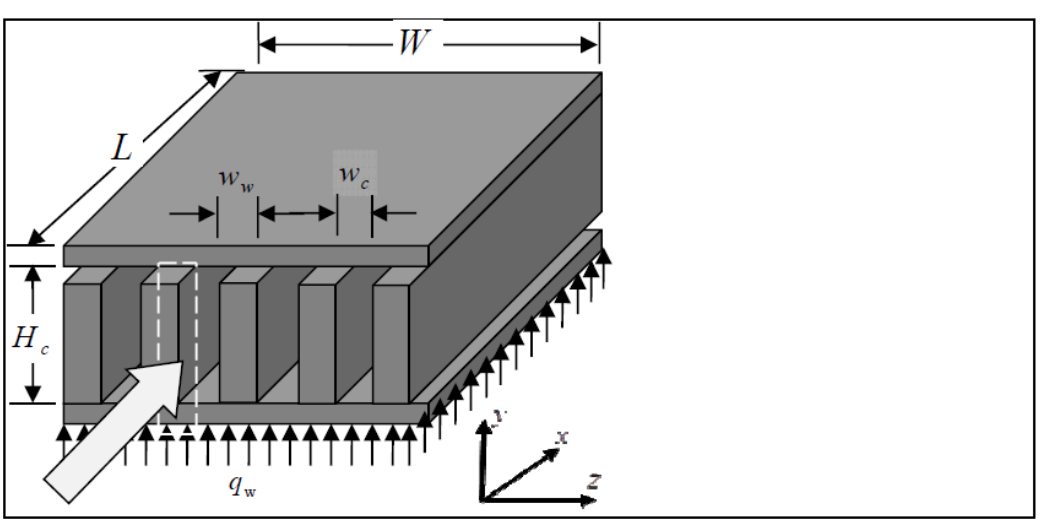
Figure 1. Geometry of the microchannel heat sink. Table 1. Assumed operating conditions.